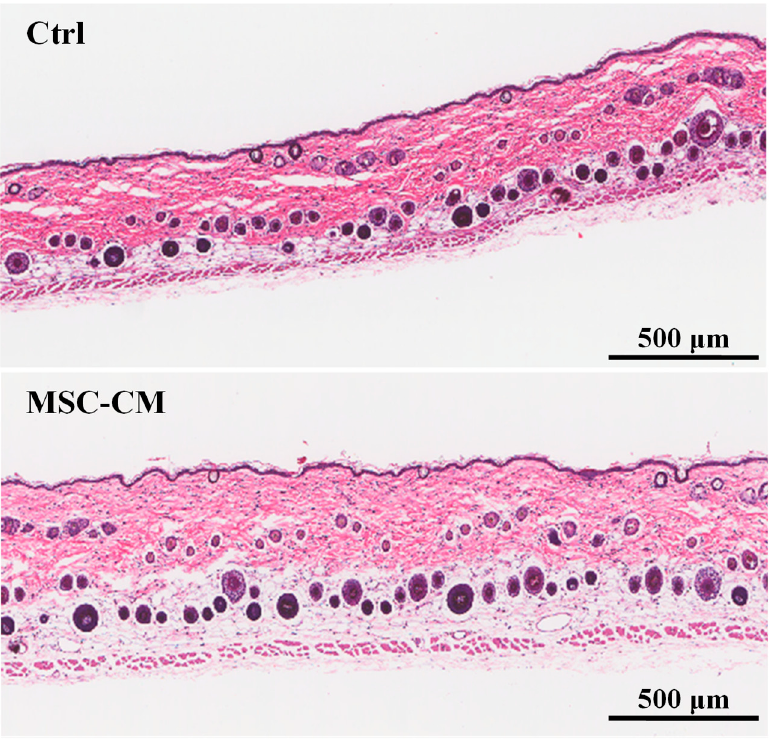
Figure 6. Histology staining of mice skins at day 15 after MSC-CM was smeared on the skin. Images from the control group ( upper ) and MSC-CM treated group ( lower ) are shown.